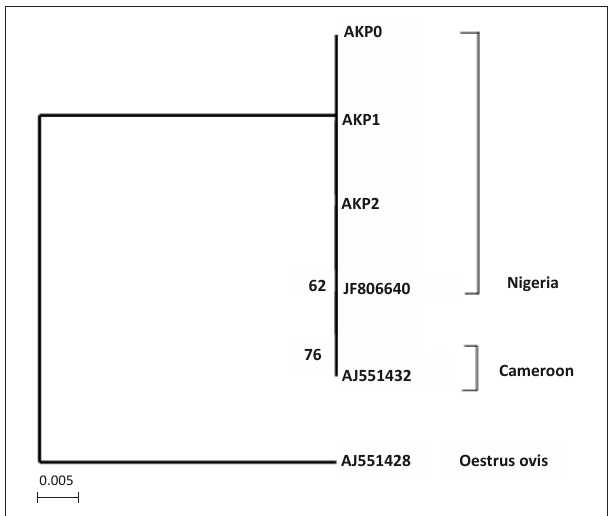
The scale bar indicates the nucleotide substitution per site. Cordylobia anthropophaga sequences detected in this work (AKP0, AKP1, AKP2 and JF806640) are highlighted. Oestrus ovis (GenBank number AJ551428) was used to root the tree. FIGURE 1: A neighbour-joining tree based on 630 base pair sequences of the 28S rRNA genes of the blowfly ( Cordylobia anthropophaga ), with 1000 bootstrap replicate